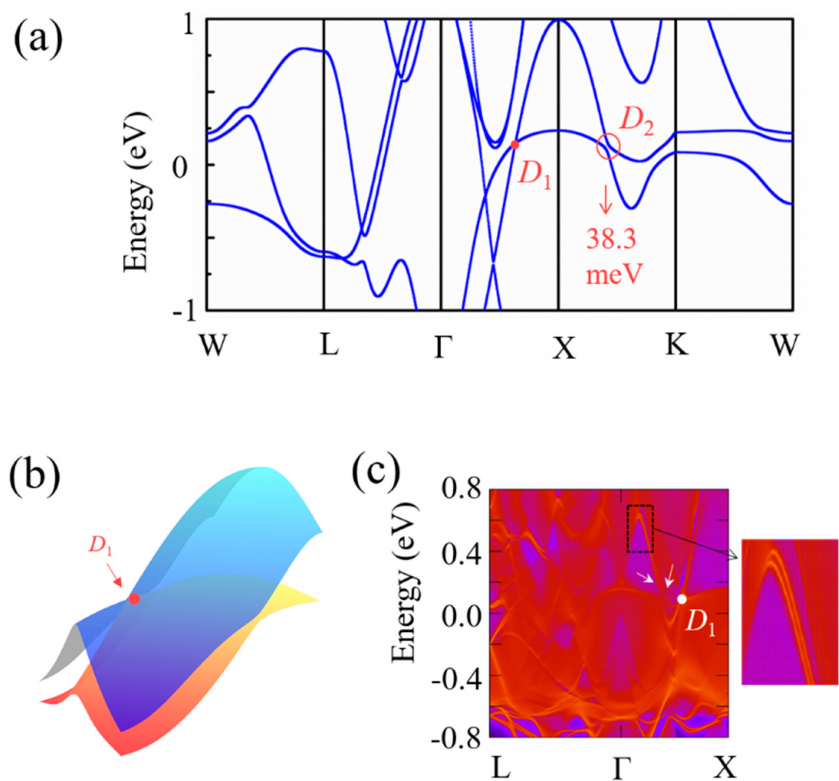
Figure 3. ( a ) Electronic band structure of Sn 2 CoS with SOC. The nodal point and gapped nodal point are indicated by D 1 and D 2 . ( b ) The 3D plot of band dispersions near the D 1 . ( c ) The surface state band structure of Sn 2 CoS with SOC. The Fermi arcs are pointed by the white